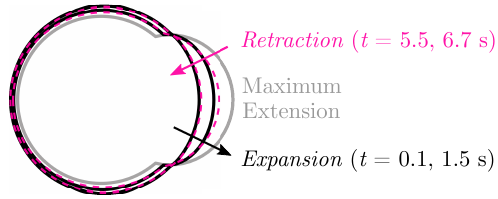
Figure 2. (Nearly) Reciprocal motion in one bleb cycle. The plasma membrane position during one bleb cycle for a cell with an elastic membrane and cortex (no cortical turnover). Membrane position is labeled in black during bleb expansion and by a dashed magenta line during bleb retraction. The bleb is fully expanded at t = 5